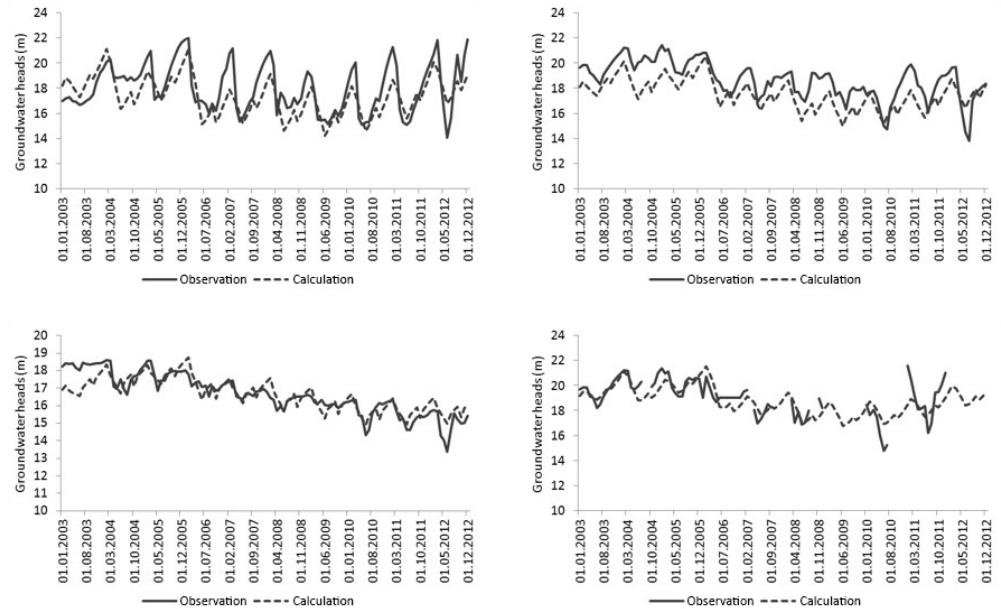
Figure 5. Calculated and observed monthly time series of groundwater heads at four available long-term observation